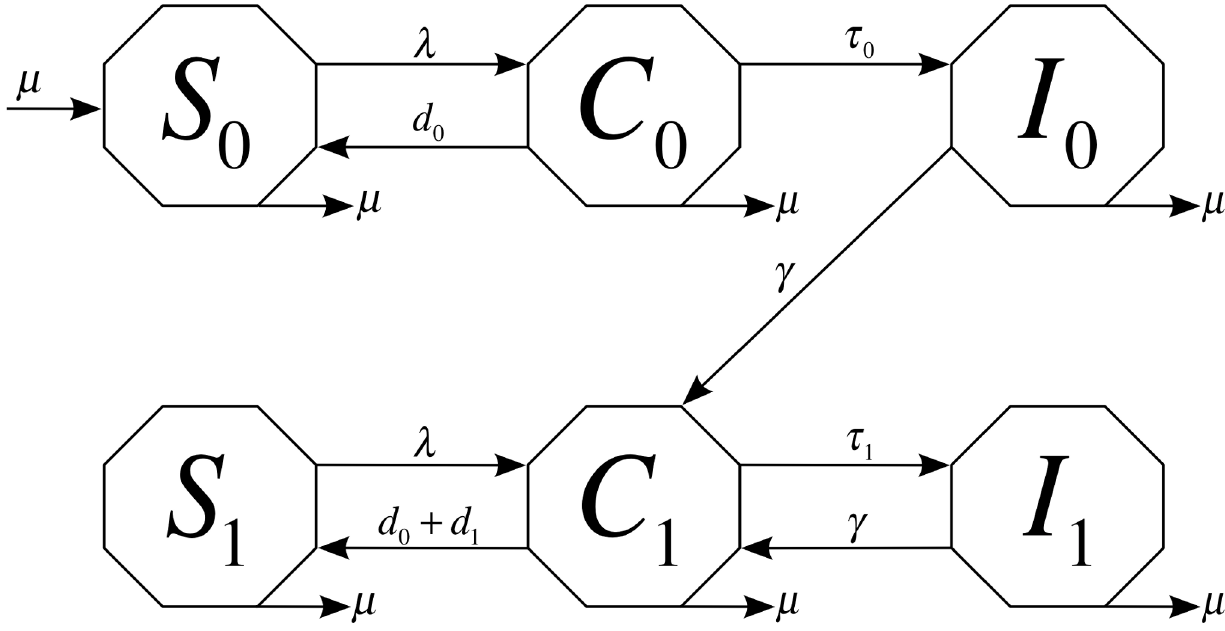
Figure 1. Flow diagram for the compartment model of the transmission dynamics of CA-MRSA for each age group. S 0 is the number of susceptible people with no prior colonization with CA-MRSA, C 0 is the number of people colonized for the first time, and I 0 are the number of people with first-time infection. S 1 , C 1 , I 1 are individuals with a history of past infections. People with infections from both groups ( I 0 and I 1 ) become colonized ( C 1 ) with a common cure rate ( c ). Further decolonization treatment (e.g. mupirocin) clears individuals and progress to the susceptible state ( S 1 ). Susceptible individuals with or without past infections progress to the colonized stage with the same force of infection l , but their progression rate from colonized to infected stages are different ( t 0 vs t 1 , respectively). Colonized individuals without past infections have only spontaneous decolonization with rate d 0 while those with past infections are subject to additional decolonization treatment with rate d 1 . m is the population immigration/migration rate per